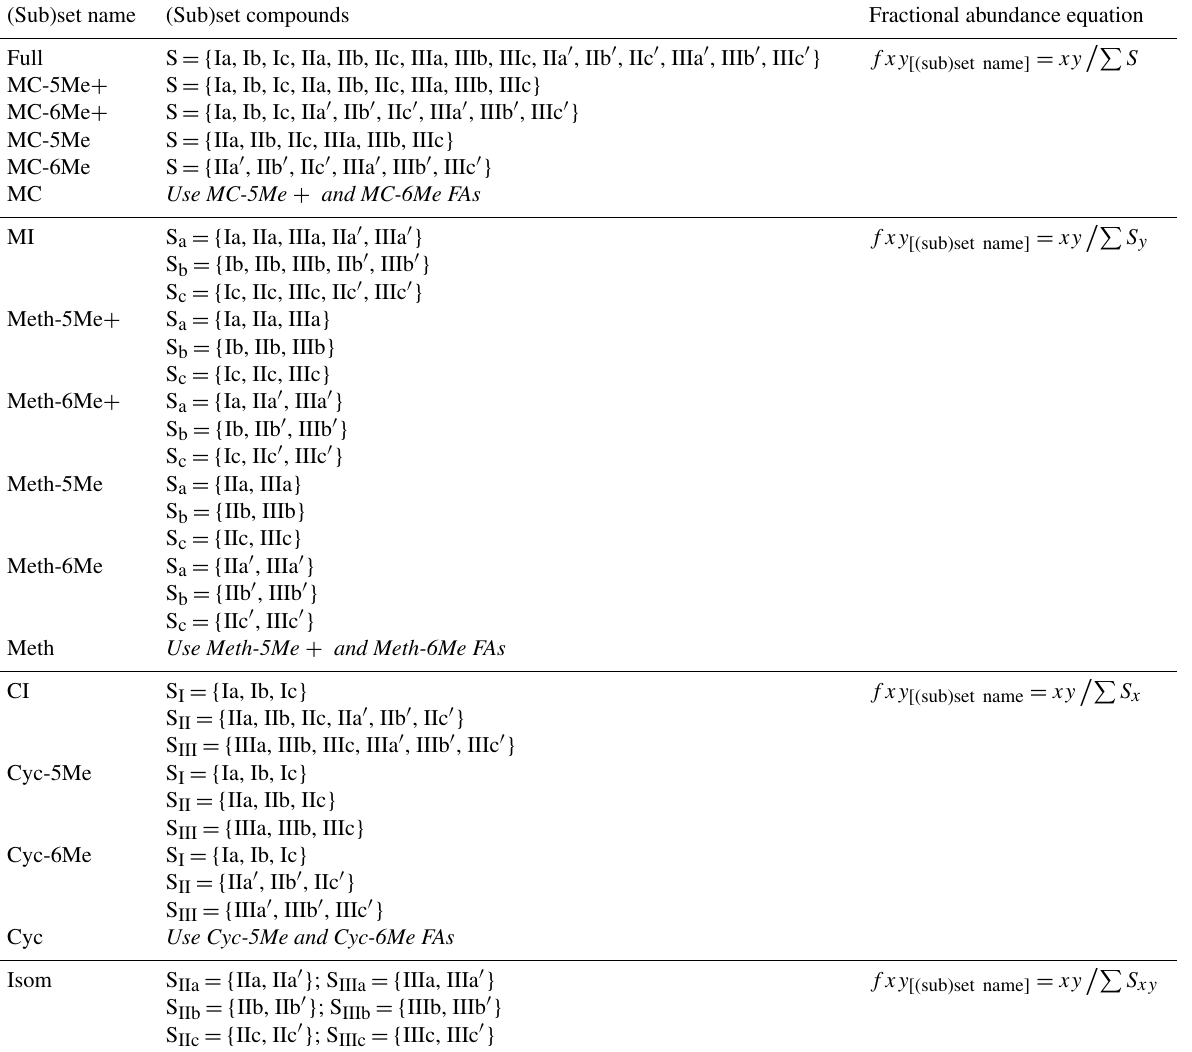
Table A1. Equations for calculating FAs within brGDGT subsets, where f xy and xy are the fractional and absolute abundances of the 5- or 6-methyl brGDGT with Roman numeral x (I, II, or III) and letter y (a, b, or